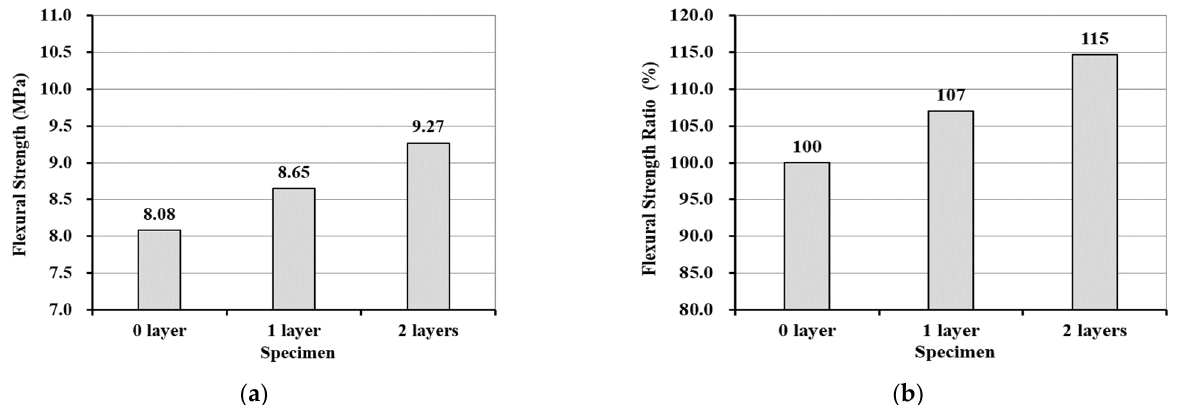
Table 2. Experimental results.